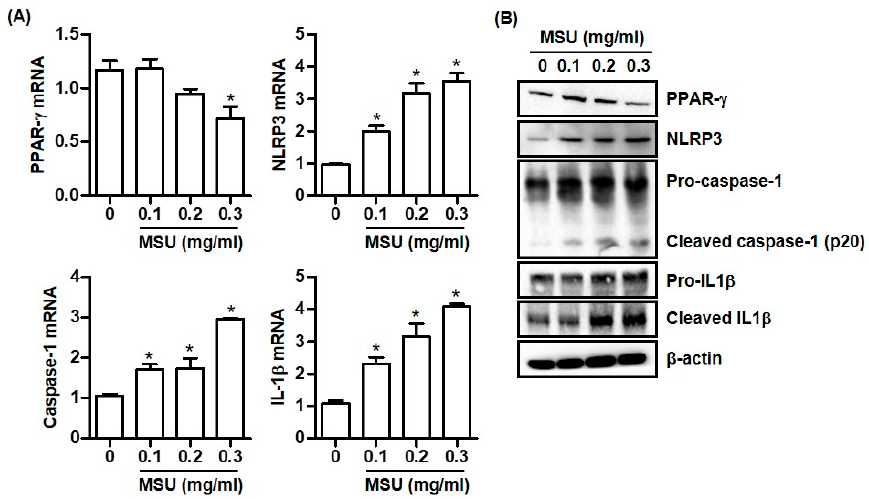
Figure 1. MSU crystals decrease PPAR- γ expression and activate NLRP3 inflammasome. ( A ) PPAR- γ , NLRP3, caspase-1, and IL-1 β mRNA expression in THP-1 cells treated with MSU crystals (0.1, 0.2, and 0.3 mg/mL) for 24 h. ( B ) PPAR- γ , NLRP3, caspase-1, and IL-1 β protein expression by Western blotting of supernatants and lysates from THP-1 cells treated with MSU crystals for 24 h. * p < 0.05 compared to cells treated without MSU crystals using Kruskal–Wallis test followed by Dunn’s multiple comparison test. Values presented as mean ± SEM of three independent experiments. The images are representative of three independent experiments. Abbreviations: PPAR- γ , peroxisome proliferator-activated receptor- γ ; NLRP3, The NACHT, LRR, and PYD domains containing protein 3; MSU, monosodium urate; and IL-1 β , interleukin-1 β .